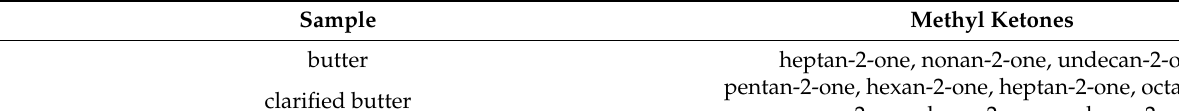
liquid vegetable fat preparation I (includes whey-based